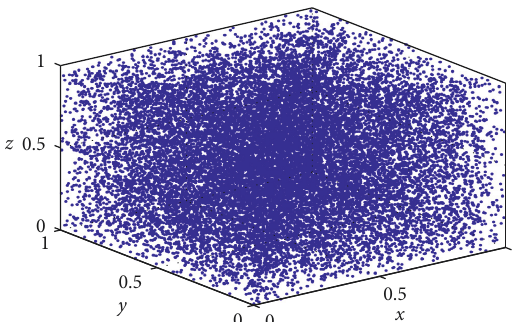
Figure 2: The chaotic attractor of 3D-PHM.